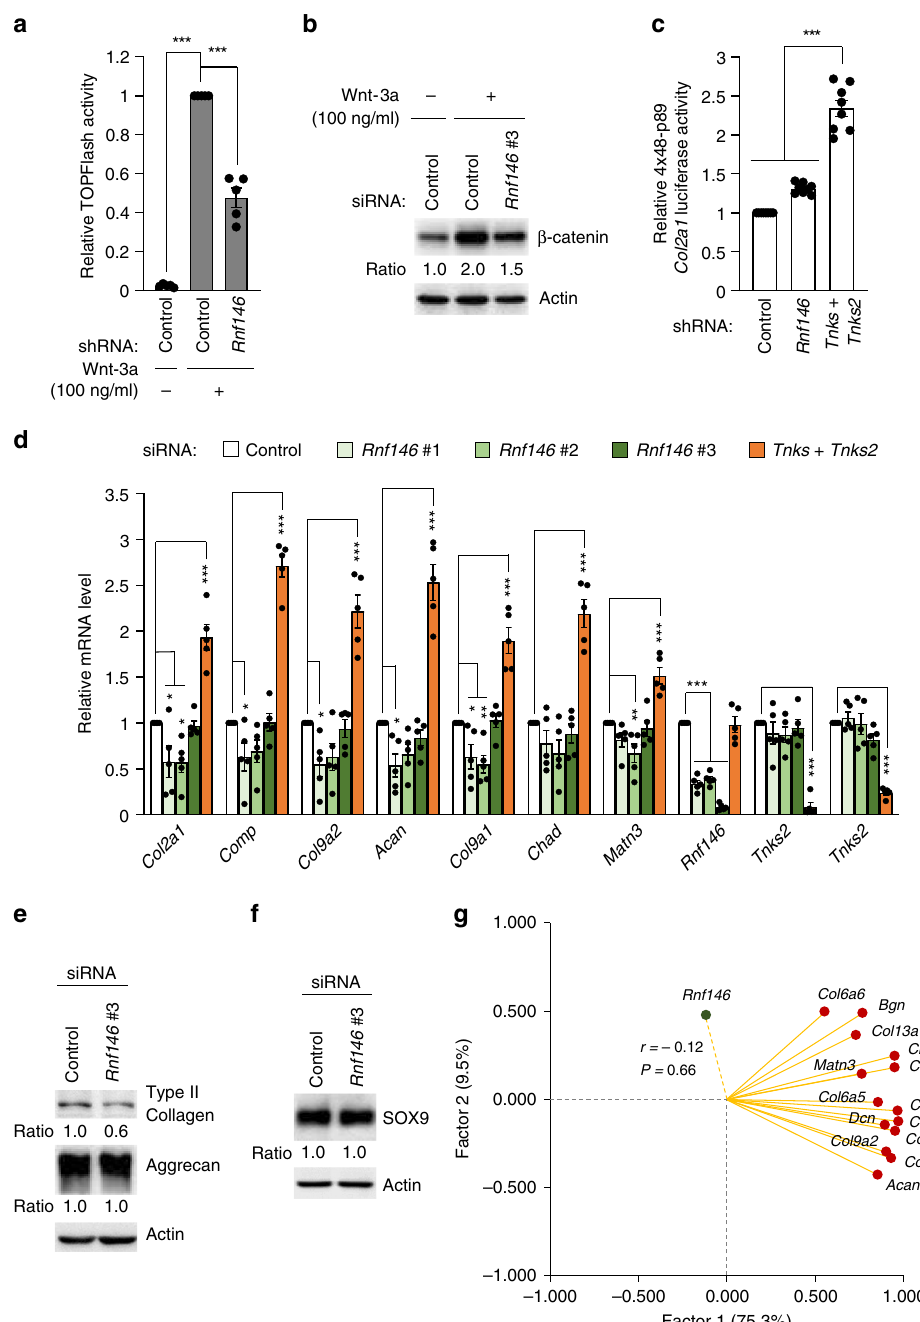
Fig. 4 RNF146 does not regulate SOX9 activity and cartilage matrix anabolism. a TOPFlash reporter assay in chondrocytes after control shRNA or sh Rnf146 transfection ( n = 5). b Chondrocyte lysates were immunoblotted for β -catenin after treatment with control siRNA or si Rnf146 . a , b Recombinant Wnt-3a was added 24 h before harvest. c A 4 × 48-p89 SOX9-dependent Col2a1 luciferase reporter assay in chondrocytes transfected with control shRNA, sh Rnf146 , or sh Tnks and sh Tnks2 ( n = 8). d mRNA levels of cartilage-speci fi c matrix genes in mouse chondrocytes treated with control siRNA, si Rnf146 , or si Tnks and si Tnks2 ( n = 5). e , f Protein levels of e cartilage-speci fi c matrix genes or f SOX9 in mouse chondrocytes treated with control siRNA or si Rnf146 . g Factor-loading plot of 14 cartilage matrix genes in the cartilage of 16 BXD mouse strains in terms of transcript abundance, with Rnf146 added to the plot. a , c , d Data represent means± s.e.m. * P < 0.05, ** P < 0.01, *** P < 0.001 by ANOVA. b , e , f The relative protein band intensity is indicated. Full-size immunoblot images are provided in Supplementary Fig. model. For the stable and prolonged delivery of tankyrase 9 days (Supplementary Fig. 6a, b). IA administration of hydrogel- inhibitors to mouse knee joints, we used injectable hydrogels mediated XAV939 or IWR-1, the two representative tankyrase made of ascorbyl palmitate 42 . Intra-articular (IA) injection of this inhibitors with different modes of actions, resulted in a signi fi cant hydrogel-based drug delivery system allowed controlled local reduction in the degeneration of cartilage matrix caused by the release of the loaded small molecule to articular cartilage over DMM (Fig. 6e – g). A concomitant increase in type II collagen and